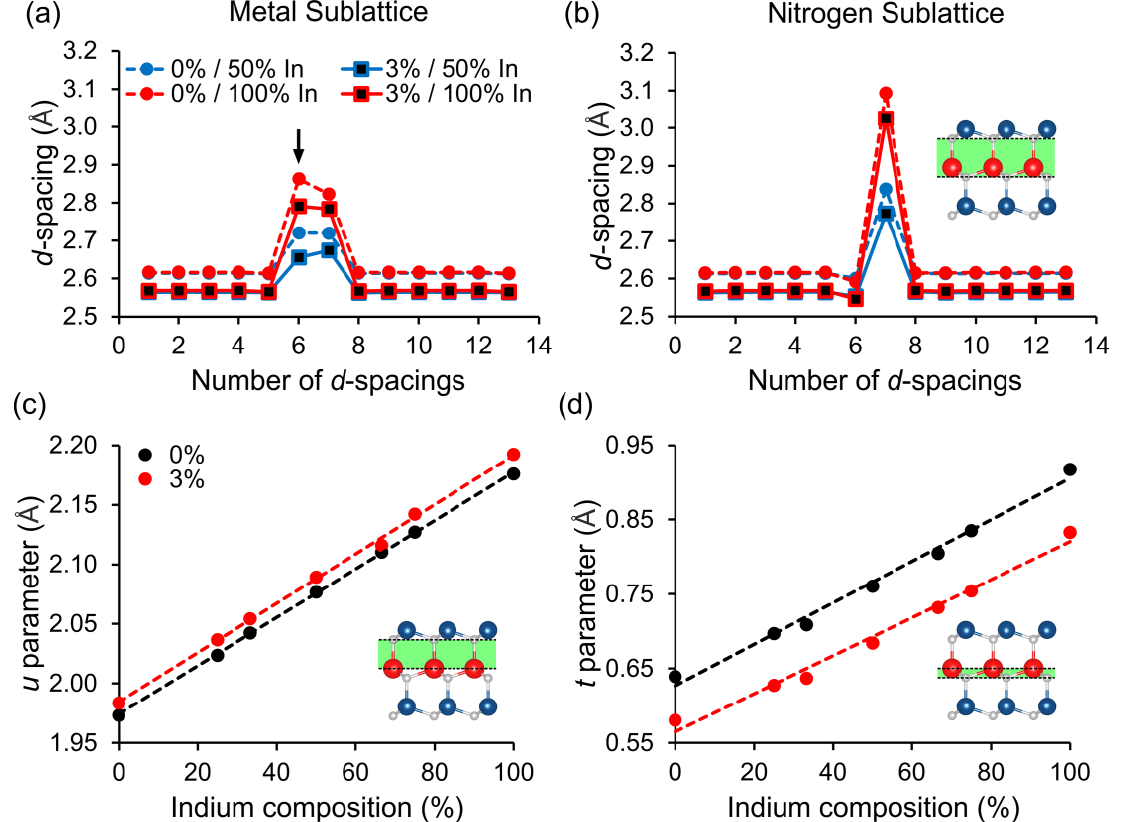
Figure 5. ( a , b ) Profiles along [0001] of d - spacing of metal and nitrogen (0002) planes for 1 - monolayer In x Ga 1− x N quantum wells, respectively. Cases with relaxed and 3% - strained GaN barriers are given. The arrow indicates the position of monolayer quantum well. ( c , d ) Graphs with respect to composition of local internal parameter u of wurtzite structure and parameter 𝑡 = 𝑑 − 𝑢 , respectively. Illustrated parameters u and t add up to yield the maximum d - spacing of nitrogen planes of the quantum well as schematically shown in the insets.